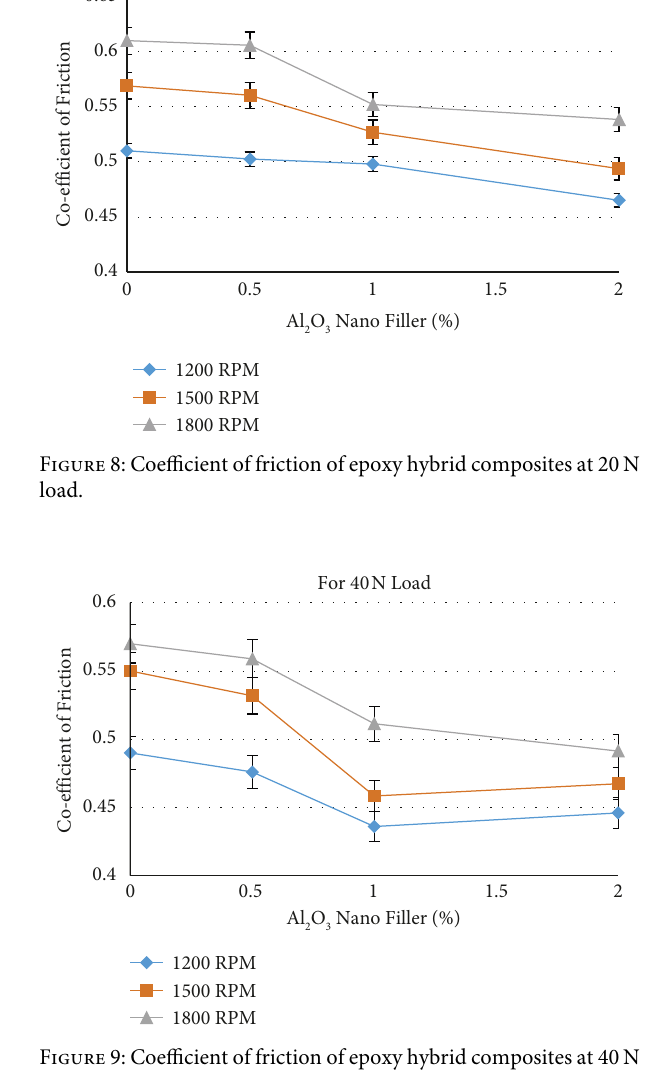
Figure 9: Coefcient of friction of epoxy hybrid composites at 40N